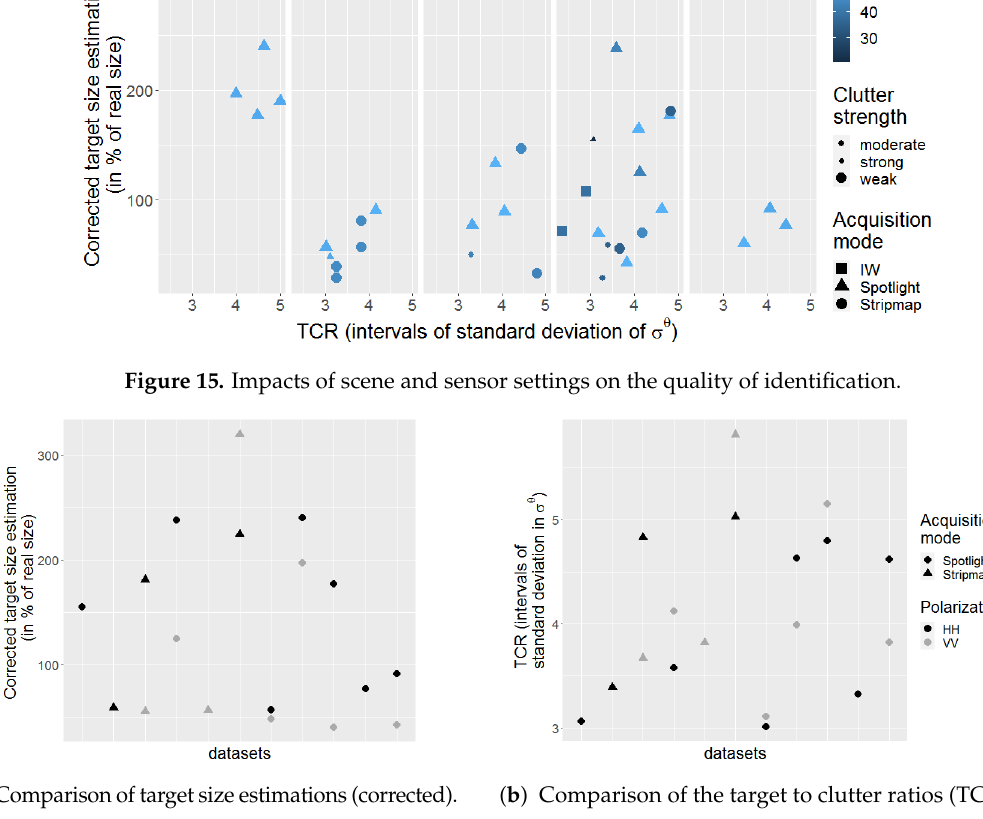
( a ) Comparison of target size estimations (corrected). Figure 16. Using dual-pol acquisitions to compare the quality of identification between HH and VV polarization. The incidence angle increases from left to